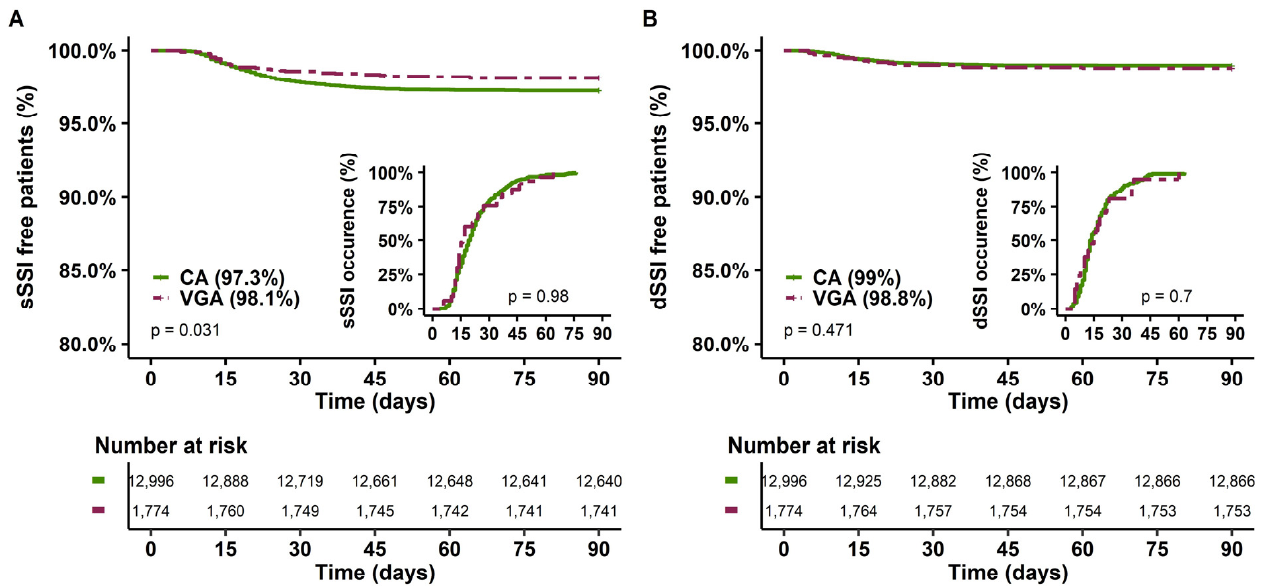
Figure 3. sSSI-free and dSSI-free patients at 90 days and delay of SSI occurrence according to the type of prophylaxis. ( A ) Superficial SSI; ( B ) Deep SSI. CA: cephalosporin antibiotic prophylaxis, VGA vancomycin/gentamicin antibiotic prophylaxis. SSI, surgical site infection.